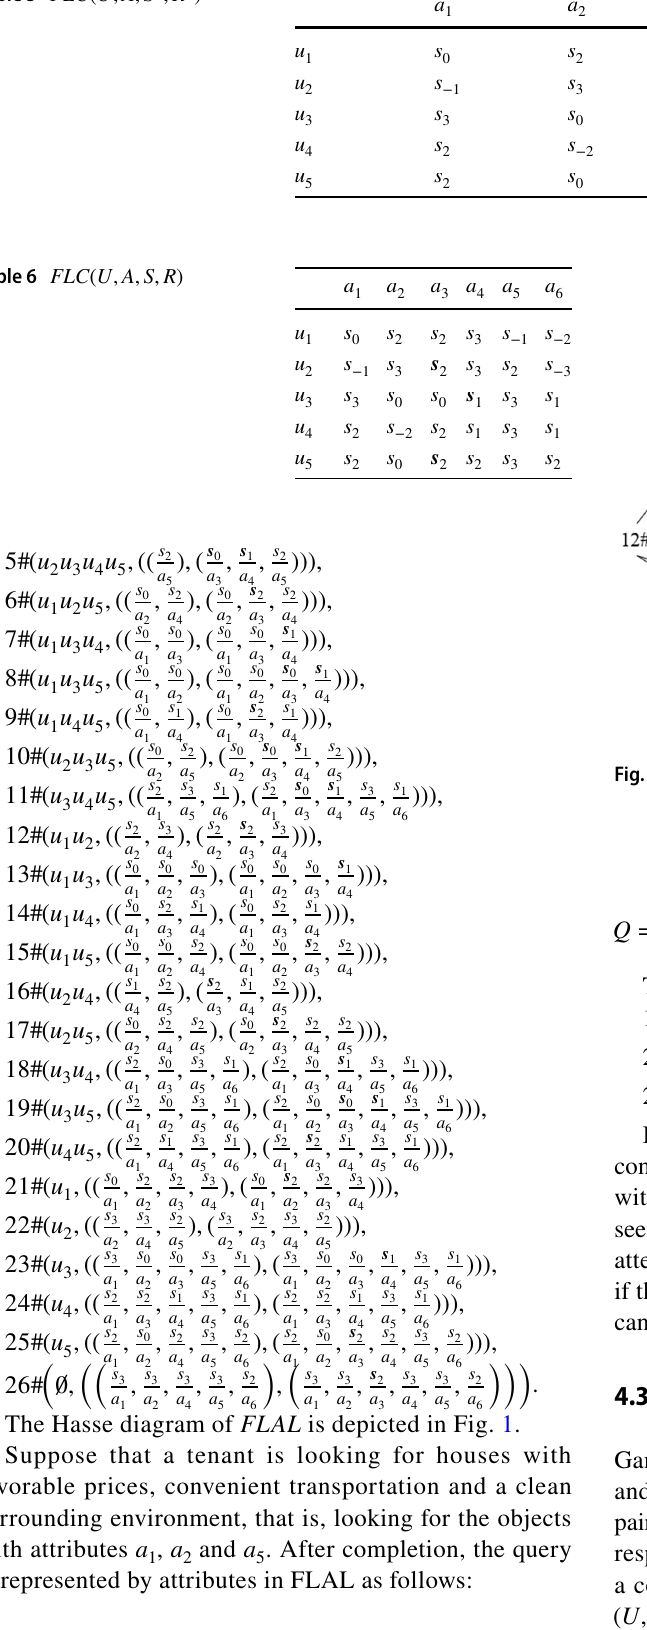
Table 5 FLC ( U , A , S ∗ , R ∗ )